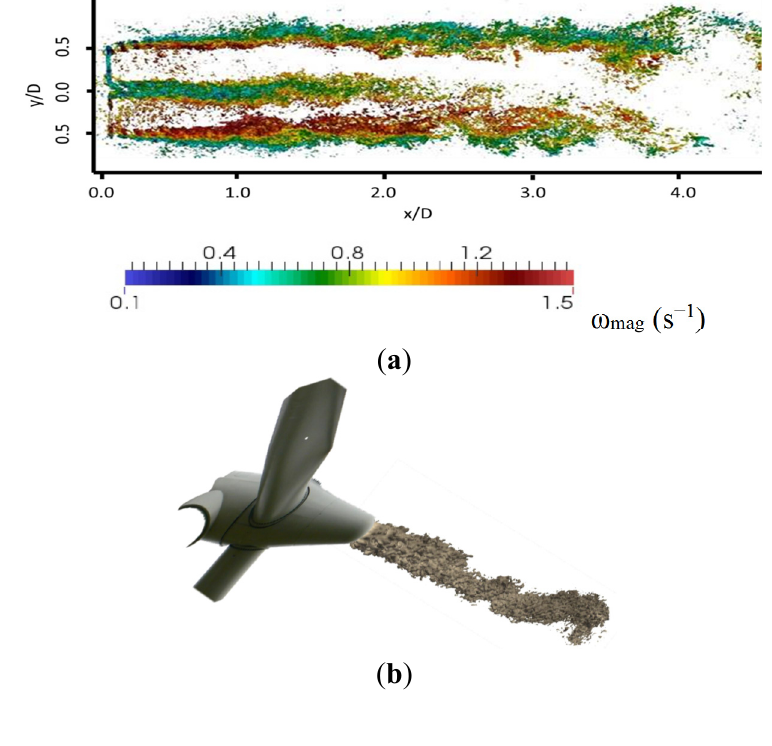
Figure 14. Wake meandering of the root vortex in low-stable regime: ( a ) magnitude of vorticity at the hub-height; ( b ) iso-contours of velocity in the region x/D = 0–3.5, z/H = 0.8–1.1, y/D = − 0.5 to 0.5 velocity contours in the range of (2–5 m/s) have been